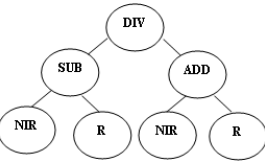
Figure 1. Normalized difference vegetation index as a genetic programming tree solution